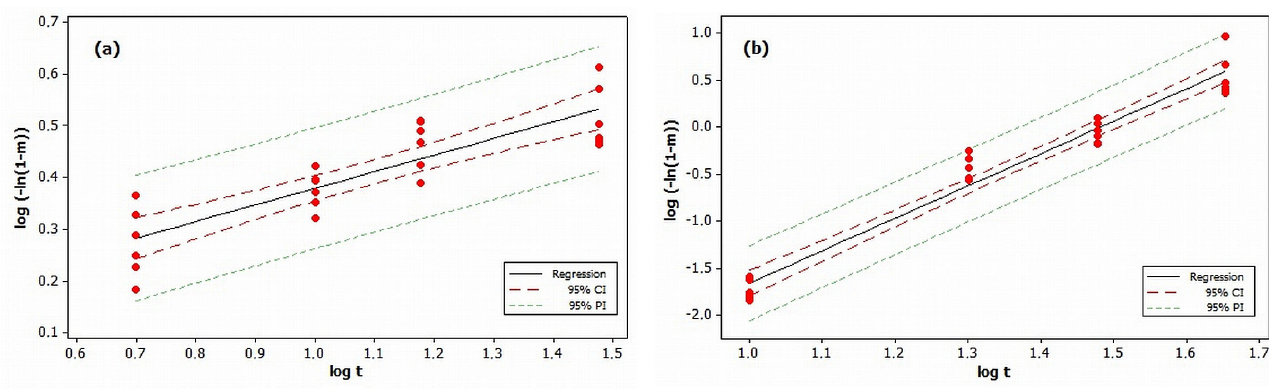
FIGURE 3 - Weibull regression for (a) MMF-IR and (b) EC-MPS profiles in selected media 0.1 M HCl and PBS pH 6.8, respectively, using UV method, λ 250